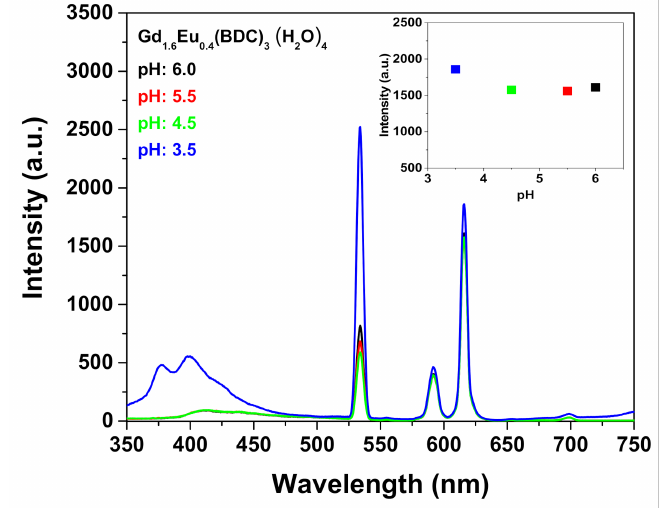
Figure 6. Emission spectra of the Gd 1.6 Eu 0.4 (BDC) 3 (H 2 O) 4 (2 mg) dispersed into aqueous solution at different pH under excitation at 265 nm. The insert reports the intensity of the peak at 615 nm in the pH range 3.5–6.